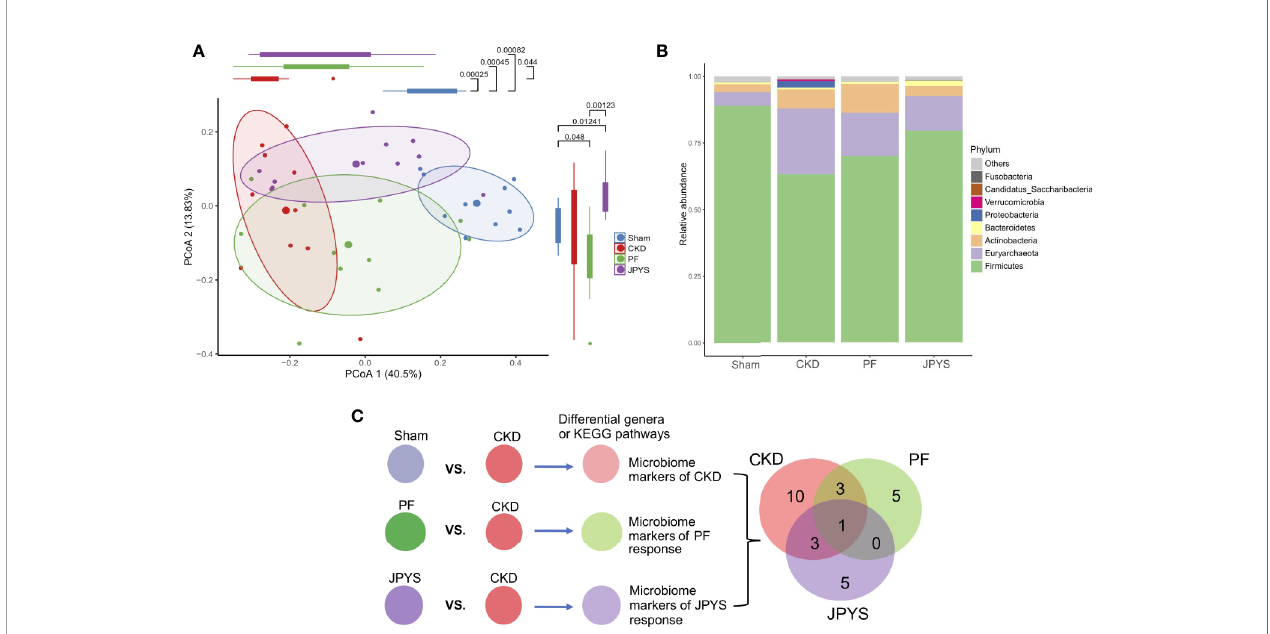
FIGURE 2 | Distinct responses of gut microbiome to JPYS and PF in the CKD rats. (A) Weighted UniFrac-based principal coordinates analysis (PCoA) of the gut microbiome of the sham-operated, CKD, JPYS, and PF rats after 12 weeks of treatment. Statistical signi fi cance of variation of the microbiomes was assessed along PC1 and PC2 respectively, tested by Wilcoxon rank-sum test with FDR correction. (B) Relative abundances of phyla across the four treatment groups. (C) Selection of genus-level microbiome markers by the Boruta algorithm and Venn diagram of the selected markers that are common or speci fi c to disease or treatment. JPYS, Jian-Pi-Yi-Shen decoction; PF, Piperazine ferulate; CKD, chronic kidney disease; PC1, fi rst principal component; FDR, false discovery